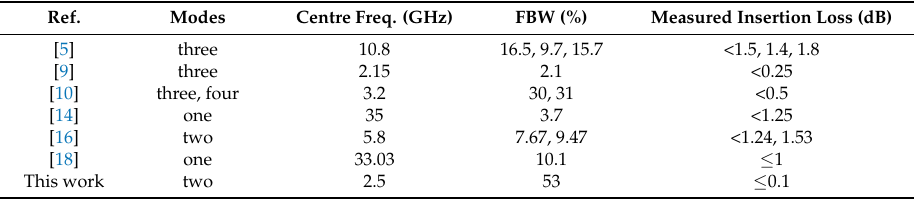
Table 1. Comparison among the cavity